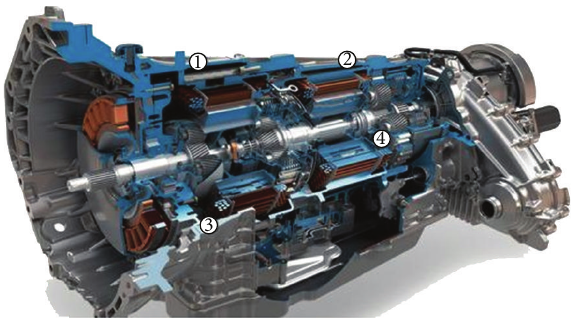
Figure 5: Transmission.